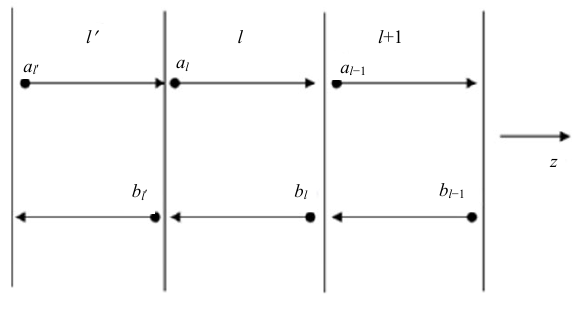
Fig. 12 Schematic of scatter matrix